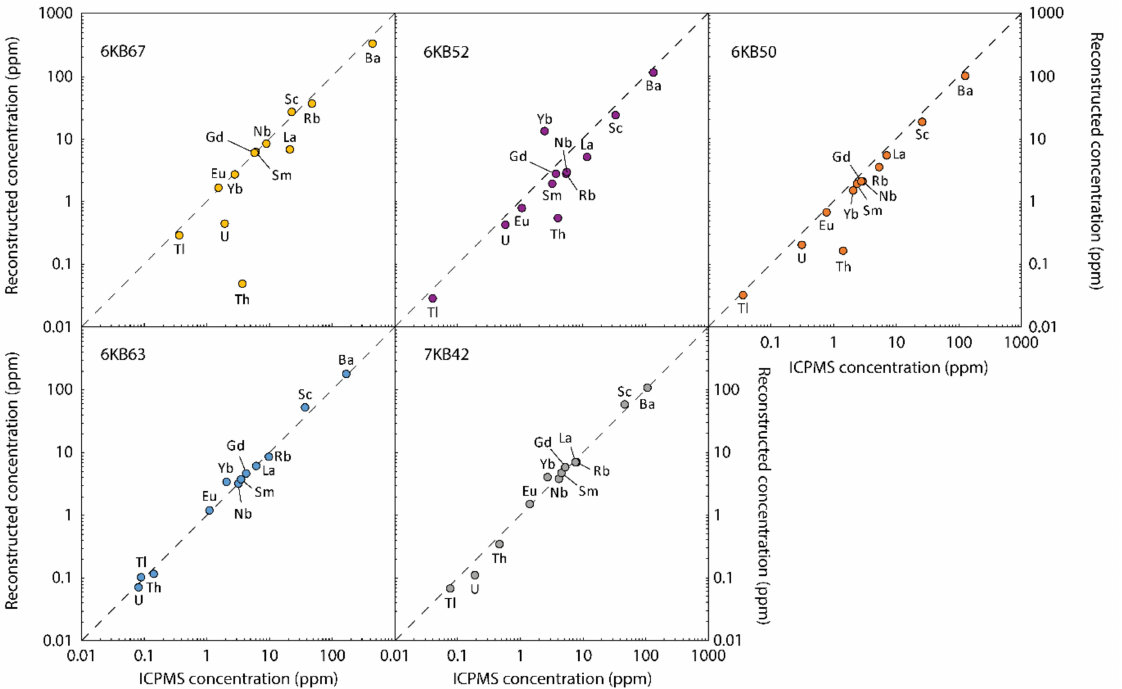
Figure 4. Comparison of trace element concentrations of the KSZ samples obtained by conventional solution inductively coupled plasma mass spectrometry (ICPMS) and by the reconstruction approach. The dashed black lines show the theoretical 1:1